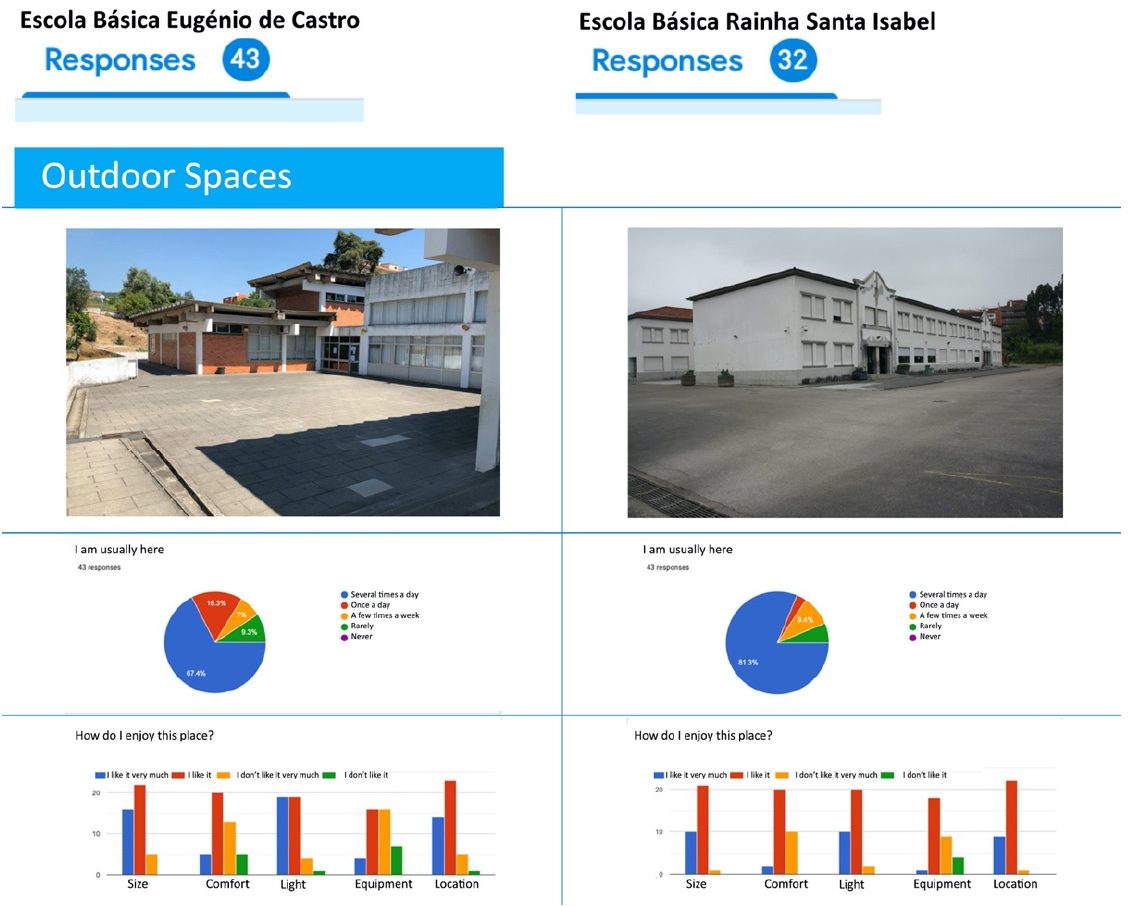
Figure 8. Sample of the comparison of questionnaire results on outdoor spaces between the two schools: EBEC ( left ) and EBRS ( right ).